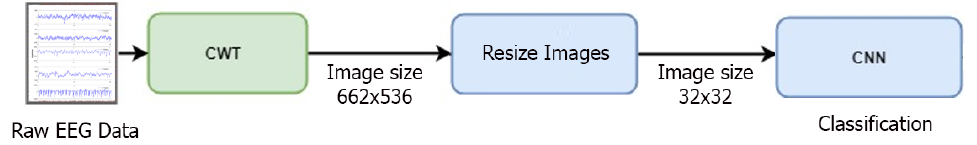
Figure 4. Followed in the study. EEG: electroencephalogram, CWT: continuous wavelet transform, CNN: convolutional neural network.